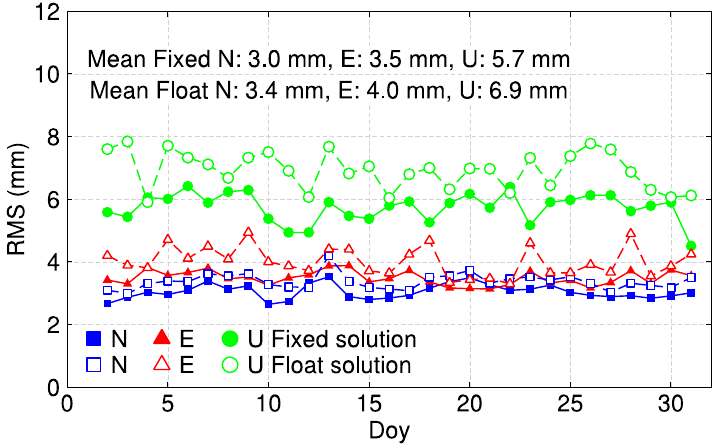
Figure 9. Averaged RMS statistics in east, north and up directions on each day during the experimental period.